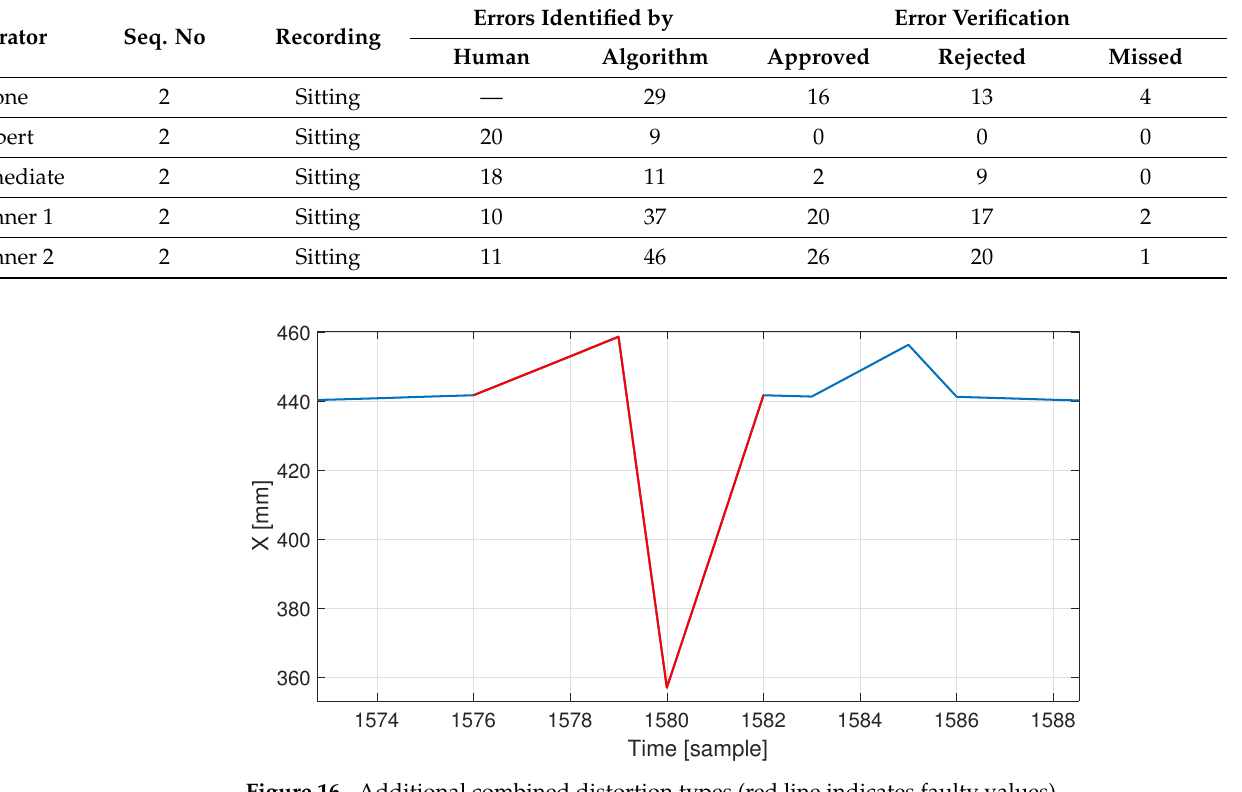
Figure 16. Additional combined distortion types (red line indicates faulty